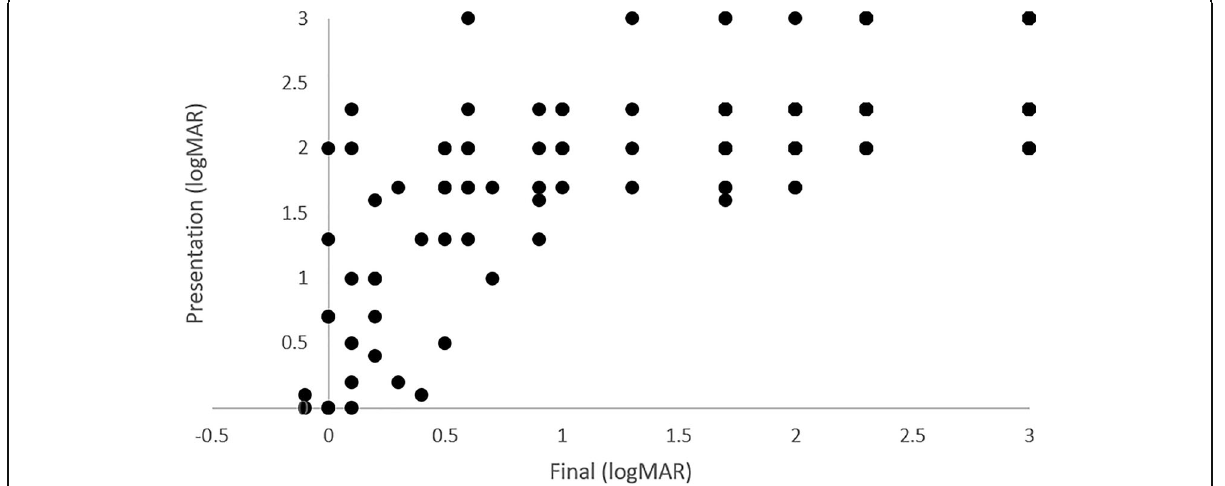
Fig. 1 Visual acuity at presentation and at final follow-up. Vision is provided in logarithm of minimum angle of resolution